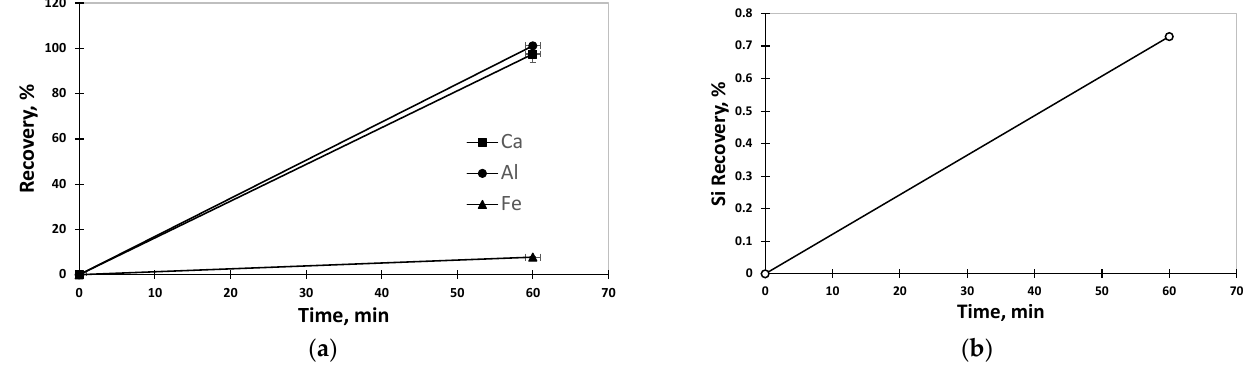
Figure 3. Time evolution of ( a ) Al recovery Ca and Fe recovery and ( b ) time evolution of Si recovery after the leaching with 5.87 M HCl, at 80 °C, agitation 300 rpm for 1 h, solid to liquid ratio (S/L) 1/10.